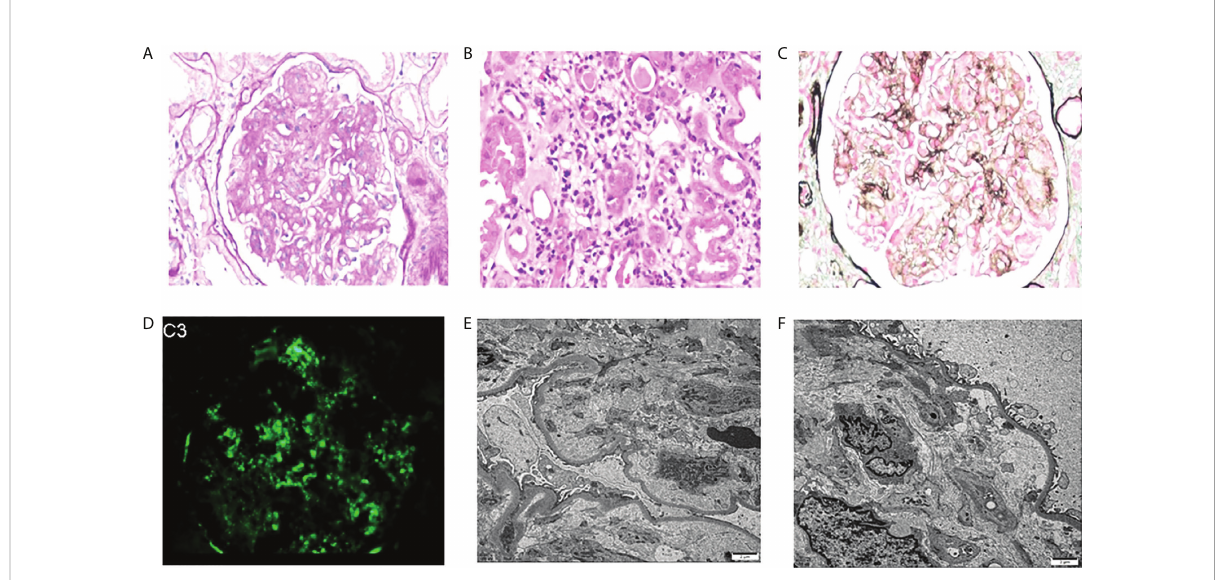
FIGURE 4 Morphologic features of C3 glomerulonephritis with thrombotic microangiopathy on renal biopsy of the patient with MGRS. (A) Mesangial cells were severely proliferated and lobulated (PAS, original magni fi cation×400). (B) Diffuse in fl ammatory cells in fi ltrate in the renal interstitium (PAS, original magni fi cation×400). (C) Endothelial cell proliferation, capillary occlusion, visible microthrombosis, and basement membrane thickening were observed by PASM-Masson (original magni fi cation×400). (D) Deposits stained with C3 in the mesangial area by immuno fl uorescence (original magni fi cation×400). (E, F) By EM, TMA-like changes were observed in the glomerulus (original magni fi cation×2500). MGRS, monoclonal gammopathy of renal signi fi cance; TMA, thrombotic microangiopathy; monoclonal gammopathy of undetermined signi fi